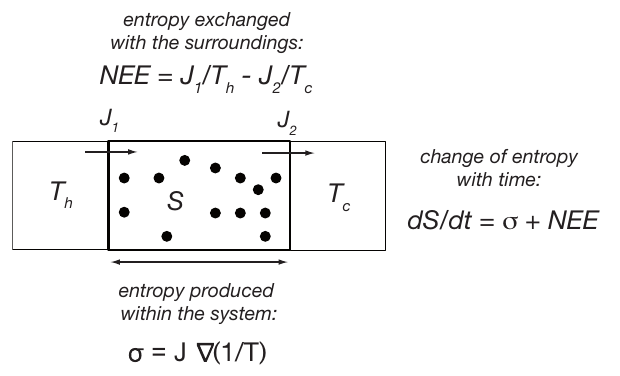
Fig. 2. The rate of change of entropy of a system over time d S /d t is a function of the entropy produced within the system σ and the entropy that is exchanged with its surroundings NEE. A heat flux J 1 from a hot reservoir at temperature T h into the system imports entropy at a rate J 1 /T h , and the heat flux J 2 from the system to a cold reservoir at a temperature T c exports entropy at a rate J 2 /T c . In steady state, J 1 = J 2 and the entropy produced within the system is balanced by the net entropy export: σ = − NEE.